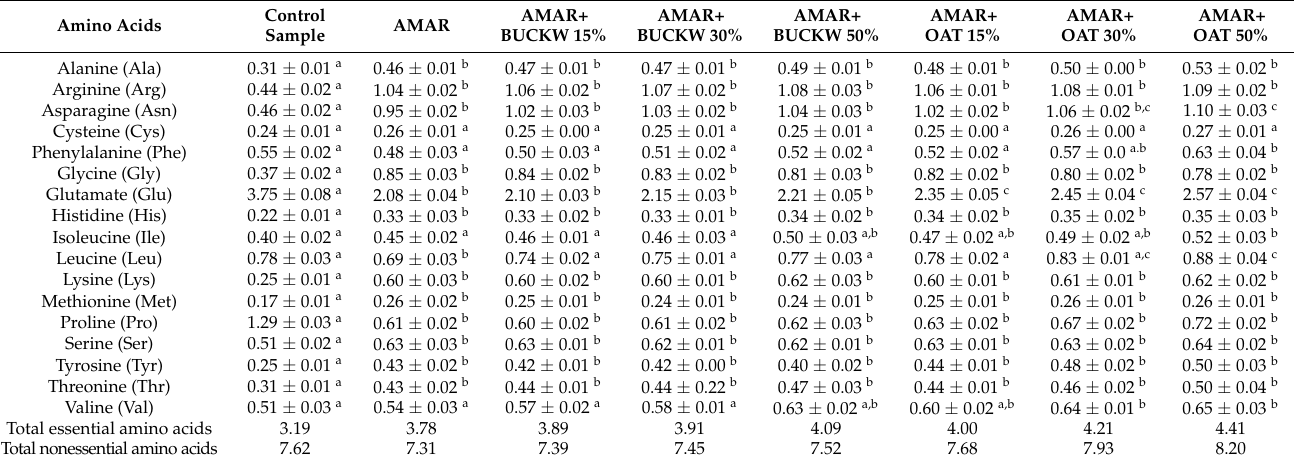
Table 4. Amino acid composition of pasta (g 100 g − 1